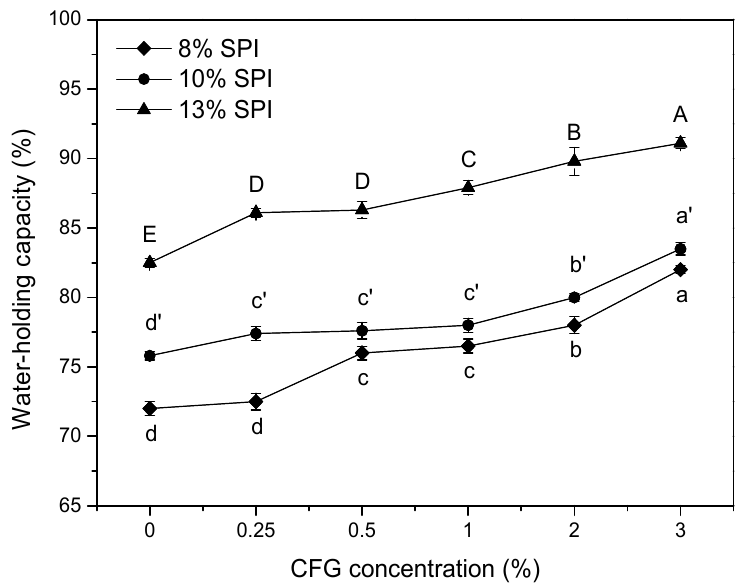
Figure 3. Water-holding capacity of CFG-SPI DN hydrogels with various CFG/SPI proportions (the concentrations of CFG and SPI were 0%, 0.25%, 0.5%, 1%, 2%, 3% and 8%, 10%, 13%( w / v ), respectively). Different letters (a–d, a ′ –d ′ , A–E) indicate statistically significant differences between different CFG concentrations when SPI is at a fixed concentration (8%, 10%, 13%, respectively).